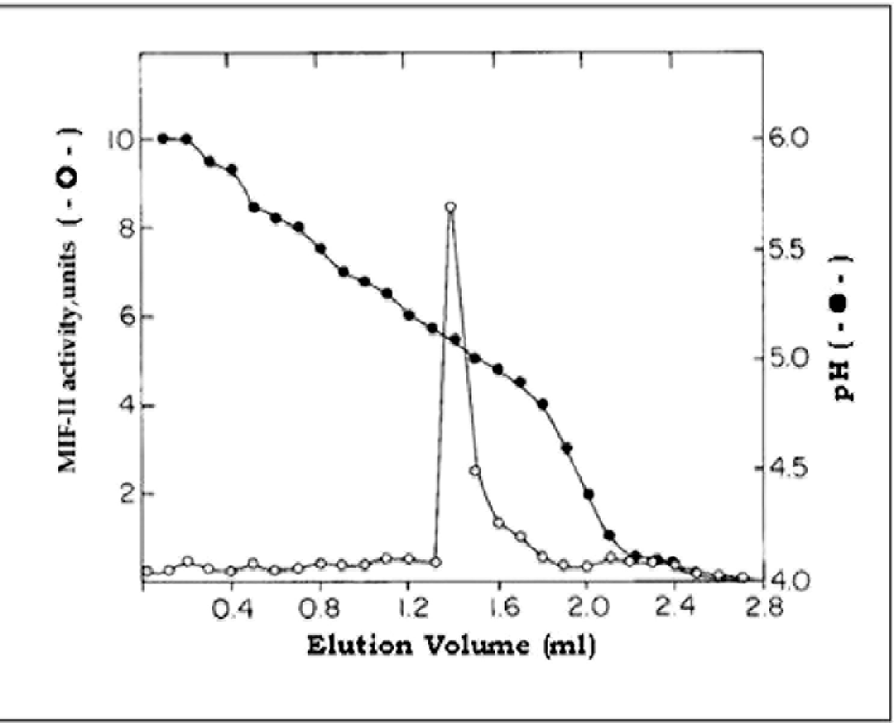
Figure 4. Isoelectric focusing of purified MIF-II using sucrose density gradients technique. Purified MIF-II was subjected to sucrose density gradient tube gel and focused according to the procedure described in ‘‘Materials & Methods’’ section.